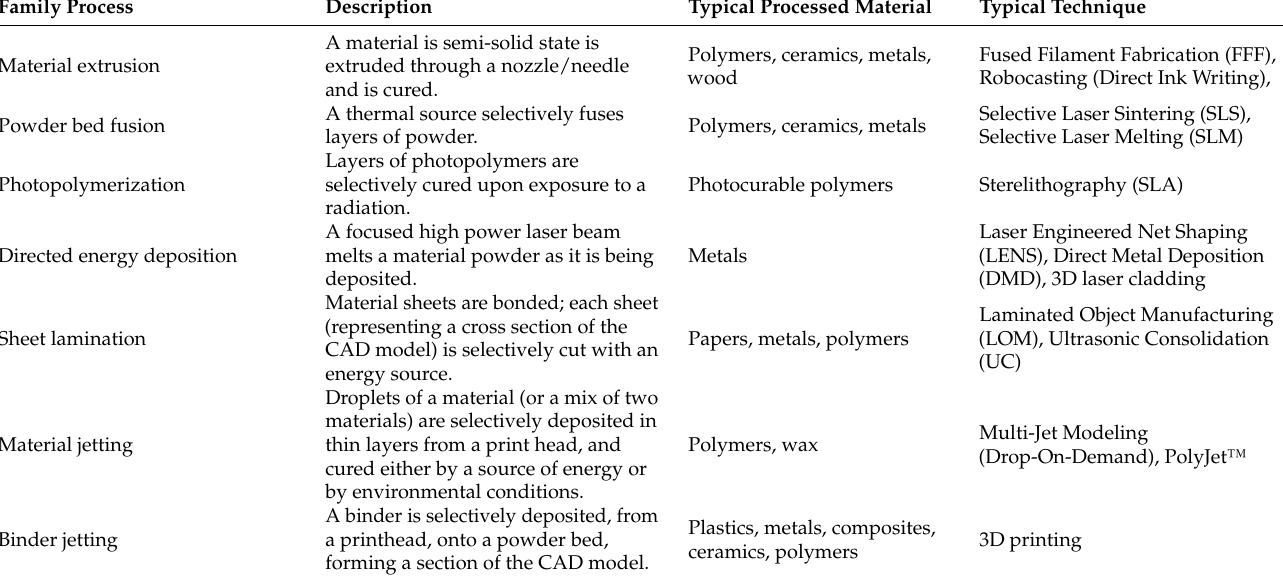
Table 1. Additive manufacturing processes